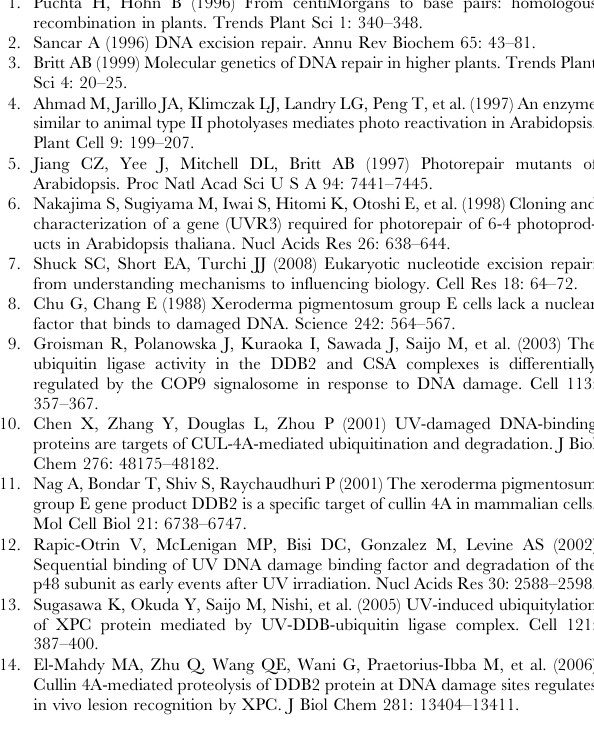
Figure S1 UV-C sensitivity of DDB1A and DDB2 overexpress- ing plants and mutants sensitivities to Cisplatin and H 2 O 2 . (A) Root-growth assay. One-week-old DDB1A and DDB2 independent overexpressor lines and WT control plants were exposed to 900 J/ m2 of UV-C. Root growth was measured 24h following irradiation. Eight independent plants were analysed per lines and the experiment was performed in triplicates. (B) One-week-old mutant ( cul4-1 , ddb1a-2 , ddb2-2 ), and WT control plants were corresponding untreated plants ( 6 SEM). Eight plants per replicate were used and experiments were triplicated. For all mutants p , 0.05, compared to WT plants. (C) One-week-old mutant ( cul4-